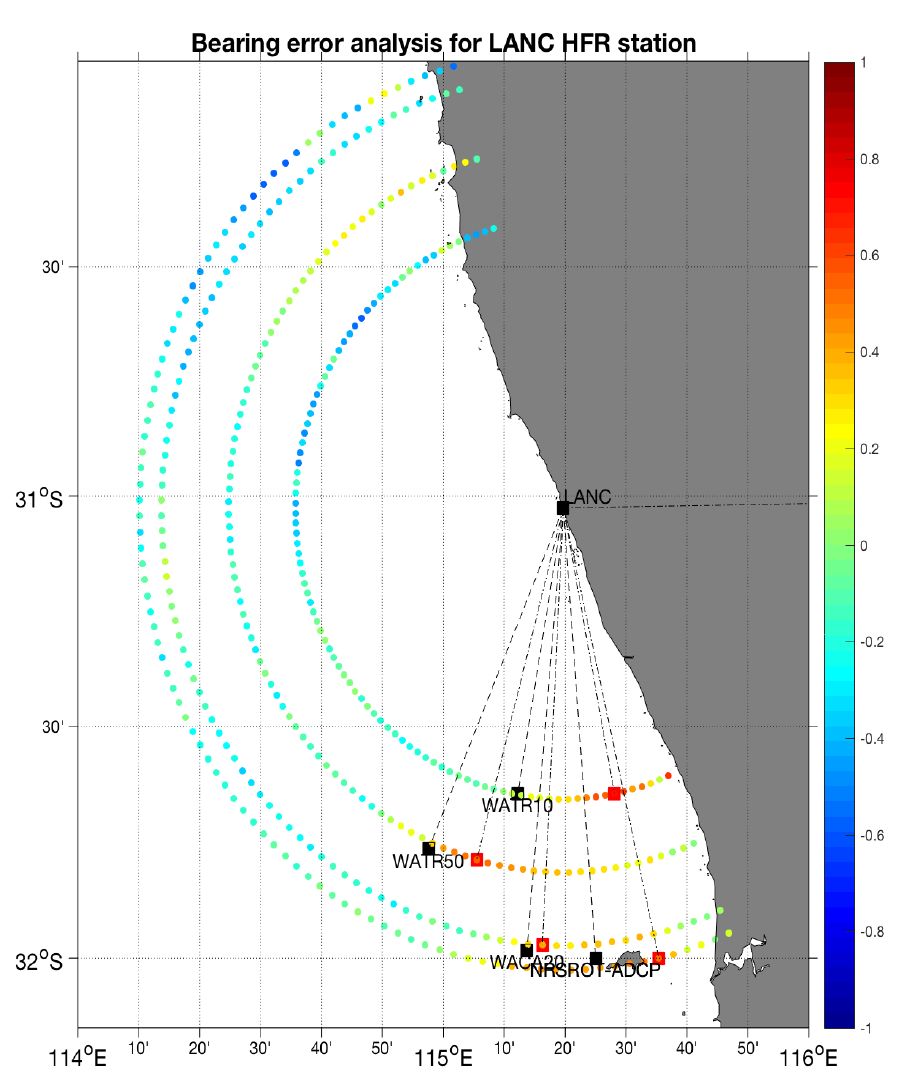
Figure 2. Bearing error analysis for LANC HFR SeaSonde site, showing the color-coded magnitude of correlation between HFR radial velocity over bearing and subsurface currents at the mooring locations. Black markers are used for the mooring locations, while red markers identify the locations that maximize the correlation at each specific range.